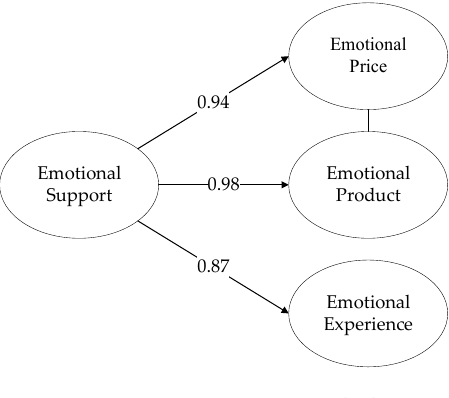
Figure 2. Emotion Support (ES).